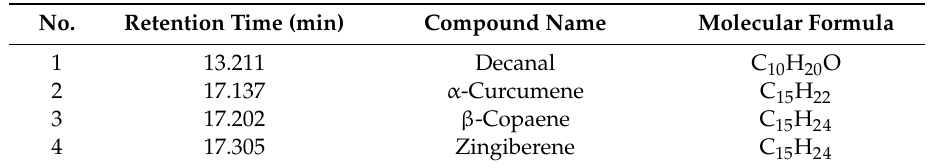
Table 1. Qualitative analysis of Angelica sinensis and Zingiber o ffi cinale Roscoe’s supercritical fluid extract (AZ-SFE) based on GC / MS